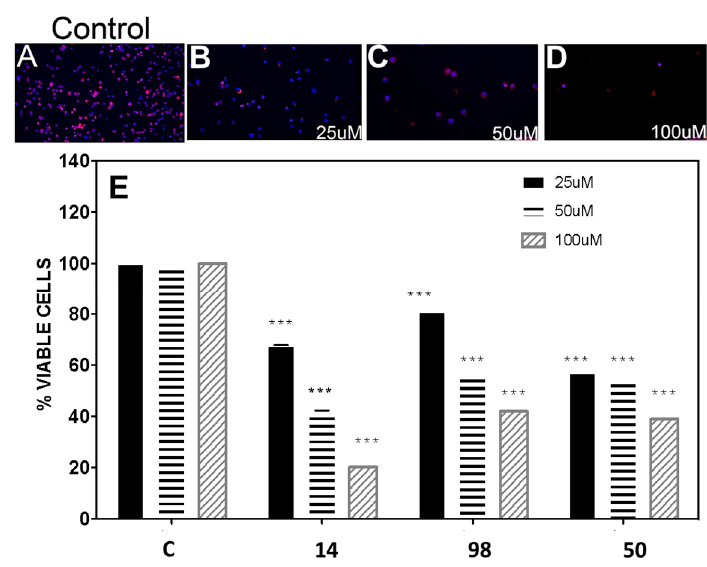
Figure 5. Figure 5. In vitro activity of selected compounds on BME26 embryonic cells from Rhipicephalus microplus . ( A – D ) Confocal fluorescent microscopy of BME26 cells incubated for 24 h with different concentrations of compound 14 . Following incubation, cells were stained with DAPI and phalloidin to observe the cell architecture (×100 magnification). ( A ) Control cells, ( B ) cells incubated with 25 μ M